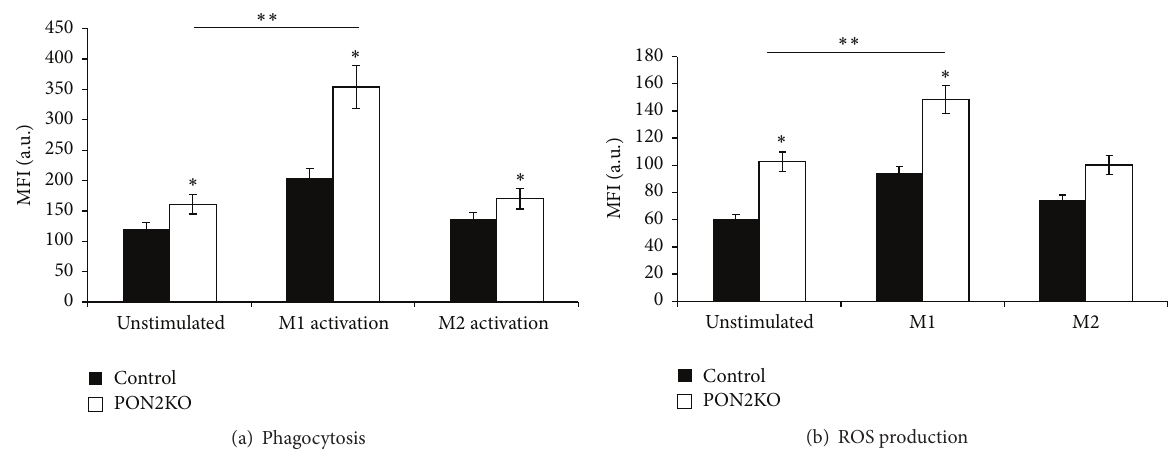
Figure 3: M1 functional phenotype in PON2KO MPM versus control mice MPM. MPM from control or PON2KO mice were either nontreated or activated to the M1 or M2 phenotype. (a) Phagocytosis was determined in cells that were incubated with FITC-conjugated latex beads for 4 hours and analyzed using FACS. Results are given as mean fluorescence intensity (MFI). (b) ROS production was analyzed by FACS and is expressed as MFI. Results are expressed as mean ± SD ( 𝑛 = 3 ), ∗ 𝑃 < 0.05 , PON2KO MPM versus control MPM; ∗∗ 𝑃 < 0.01 , M1 stimulated versus unstimulated cells.